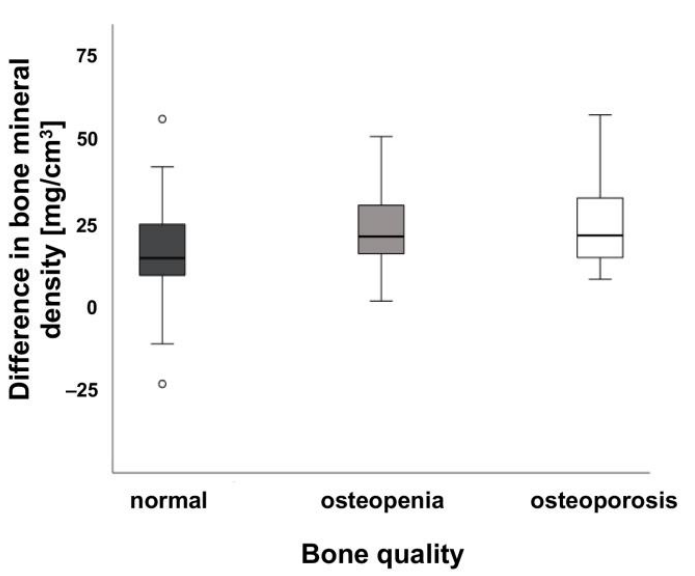
BMD native = 0.986 × BMD contrast agent application − 17.33, and for proximal femur BMD native = 1.012 × BMD contrast agent application − 4.34, respectively. Figure 5. Difference of bone mineral density (BMD) between the bone quality of control subjects (normal), and osteopenia as well as osteoporosis patients . The BMD (mg/cm 3 ) is shown on the y- axis, bone quality is presented on the x-axis. Median values are shown. Note the increased BMD in